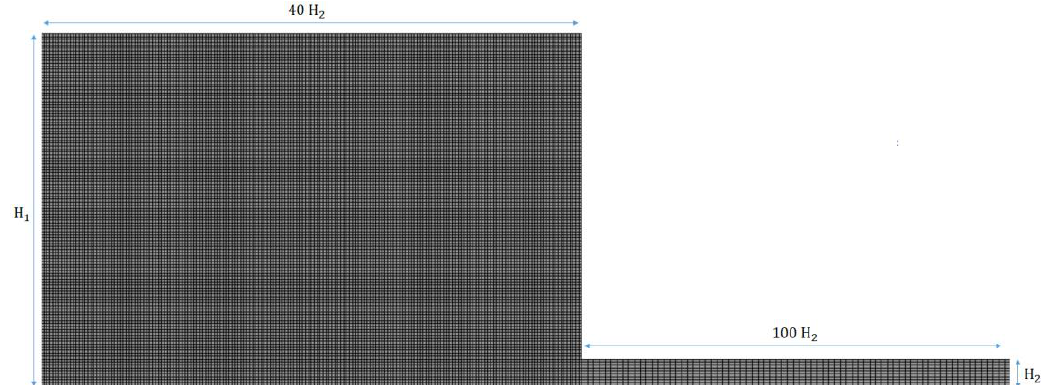
Figure 5. Magnified view of the mesh near the contraction plane.